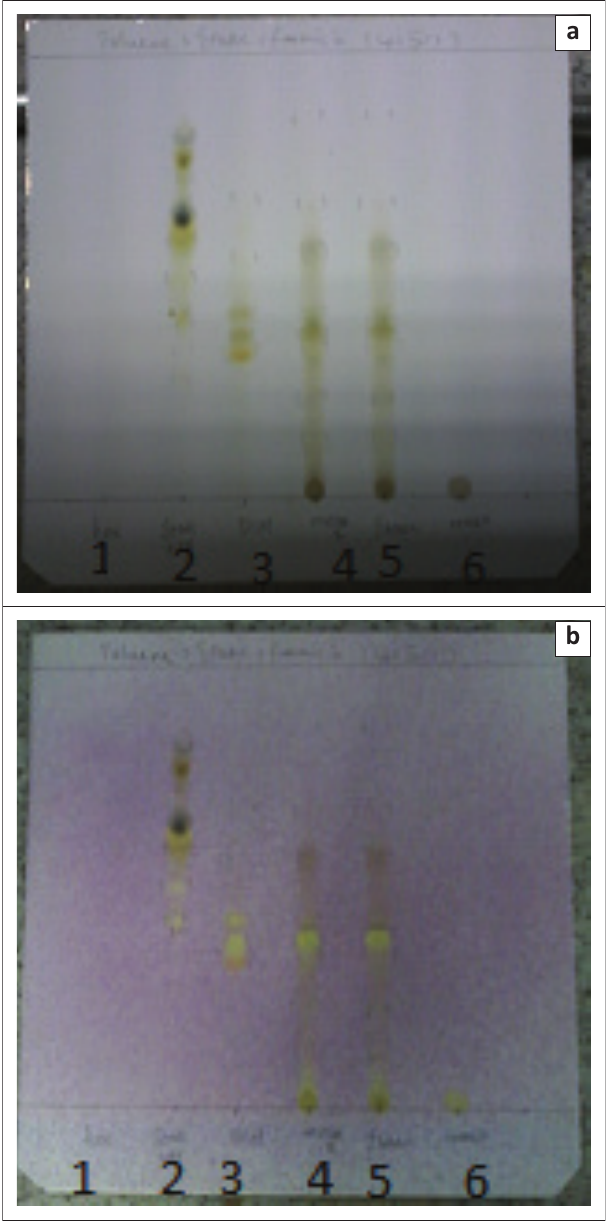
FIGURE 3: Bioautography analysis of subfractions of the dichloromethane fraction using (a) normal light and (b) UV light. Lane 1: hexane (oily/yellow), lane 2: ethyl acetate:hexane (4:6) (oily/green), lane 3: dichloromethane (solid/ brown), lane 4: acetone (solid/green), lane 5: ethyl acetate (solid/green), lane 6: methanol